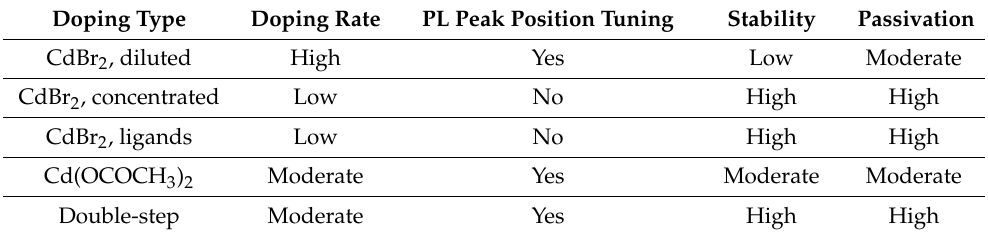
Table 1. The summary of CsPbBr 3 NPls doping with Cd 2+